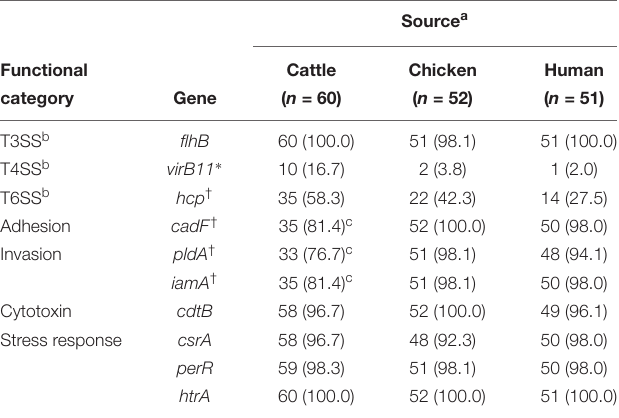
TABLE 3 | Comparison of virulence and survival-associated genes in C. jejuni isolates from different